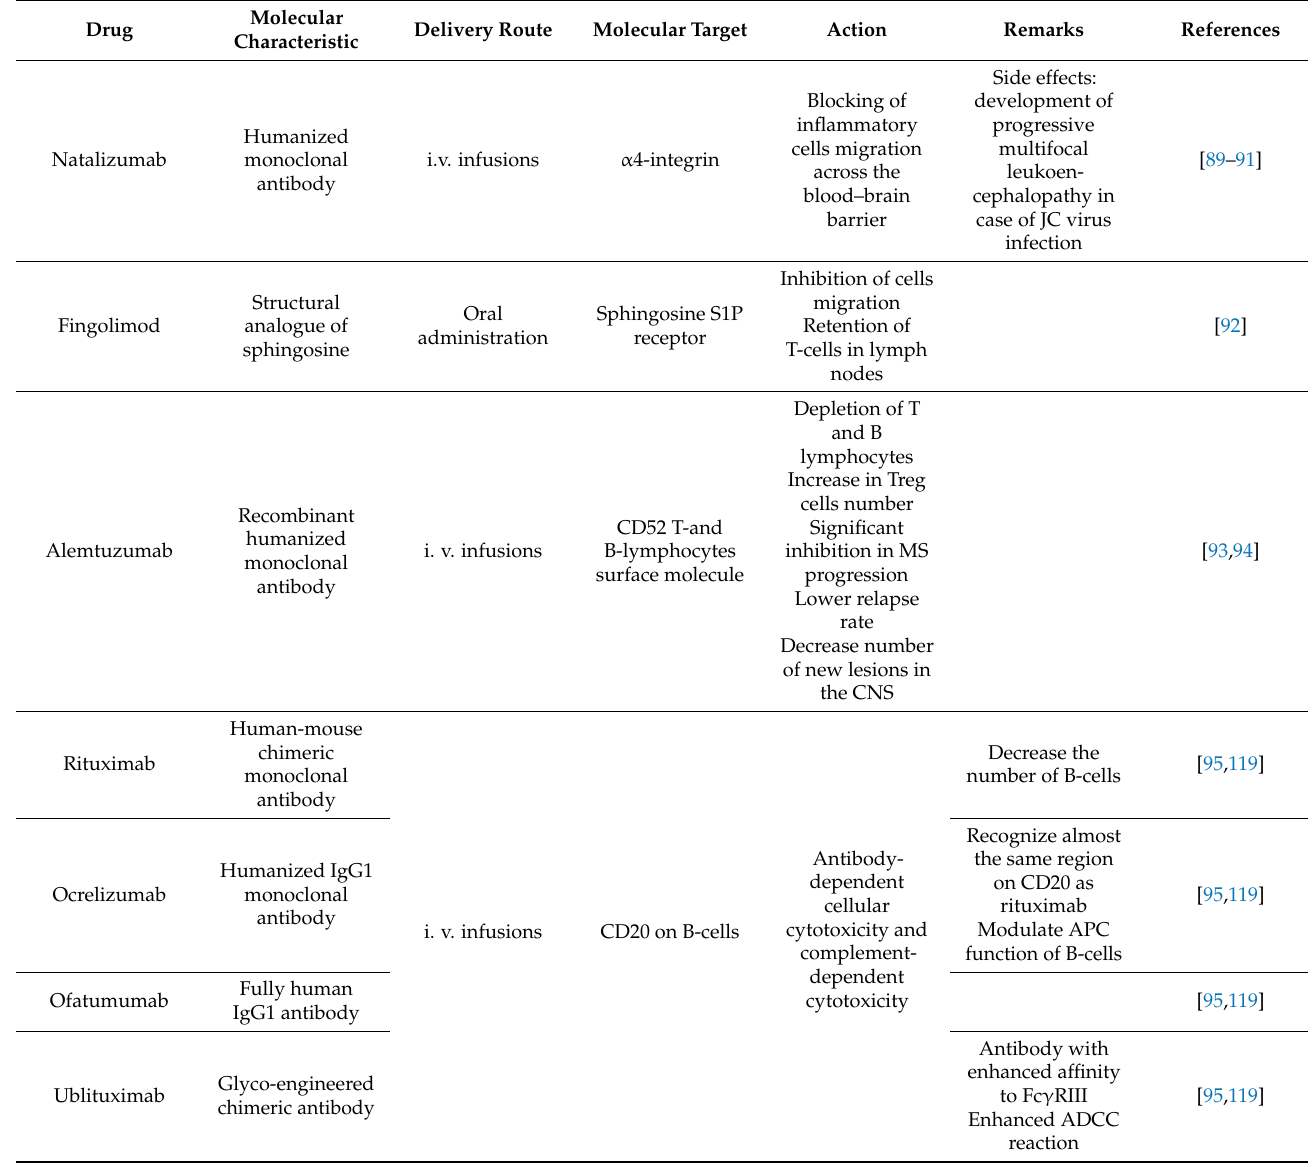
Table 1. Immunomodulatory drugs for multiple